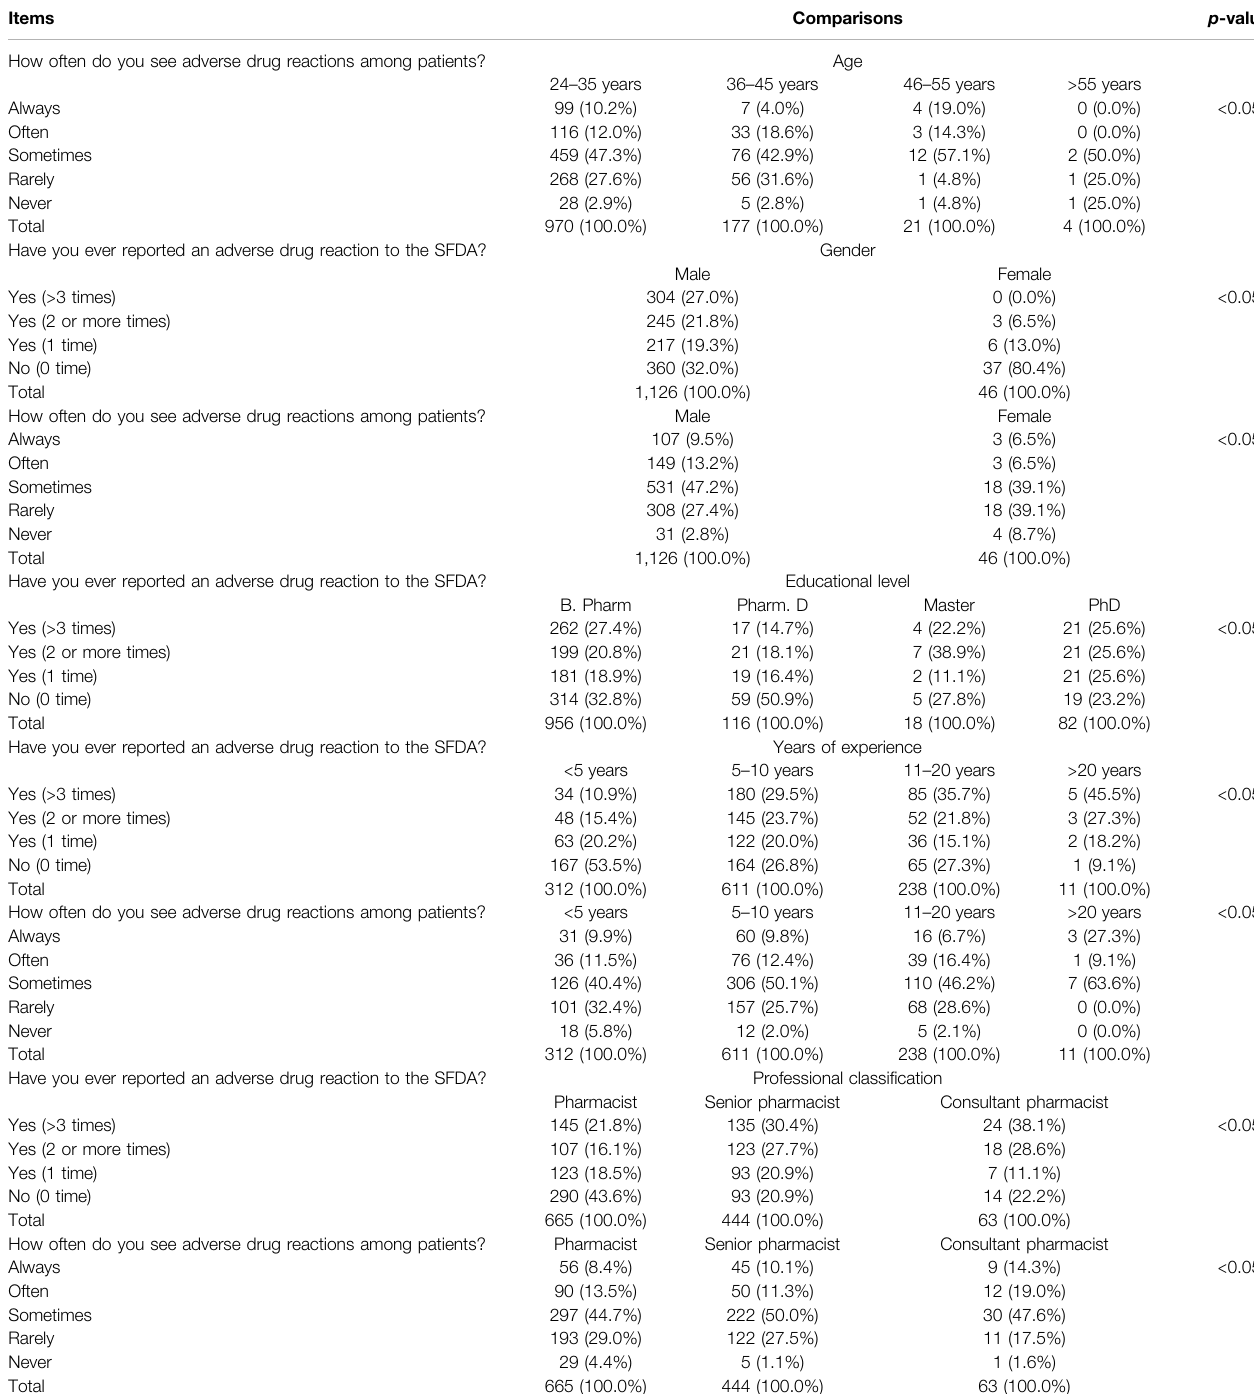
TABLE 6 | Pharmacovigilance and adverse drug reaction reporting practices of community pharmacists depending on the characteristics of the